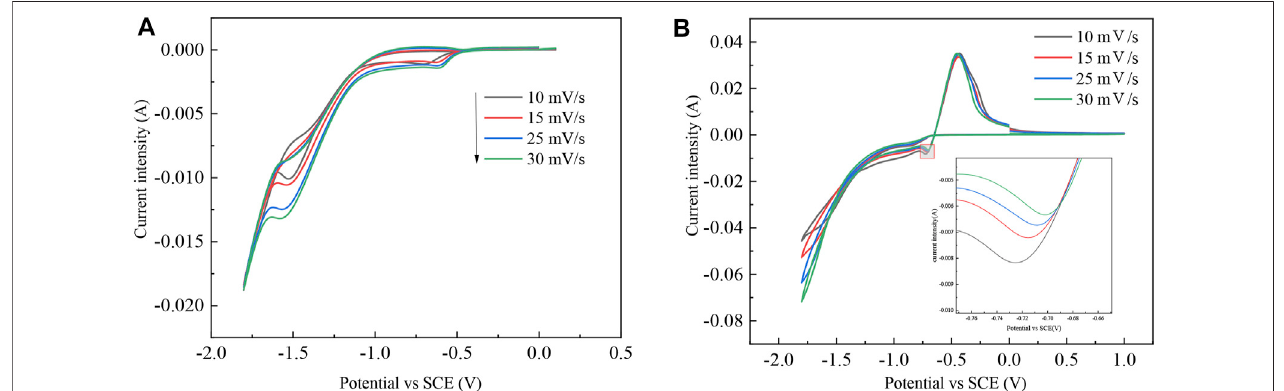
FIGURE 1 | CV curves containing different electrolytes: (A) 0.07 mol/L Na 2 SO 4 and (B) 0.03 mol/L In 2 (SO 4 ) 3 and 0.07 mol/L Na 2 SO 4 .